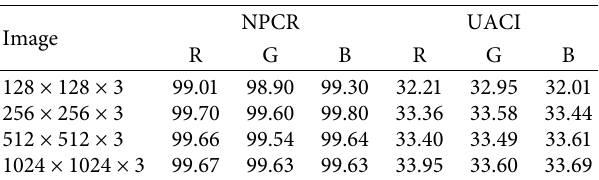
Table 7: NPCR and UACI measures for different sizes of Lena